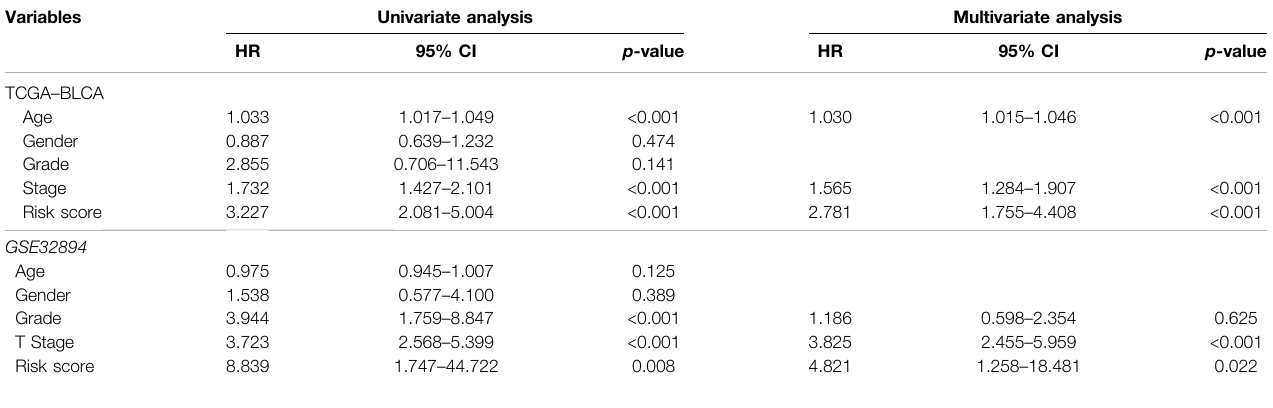
TABLE 2 | Univariate and multivariate Cox regression analysis in TCGA and GSE32894 cohort. Variables Univariate analysis Multivariate